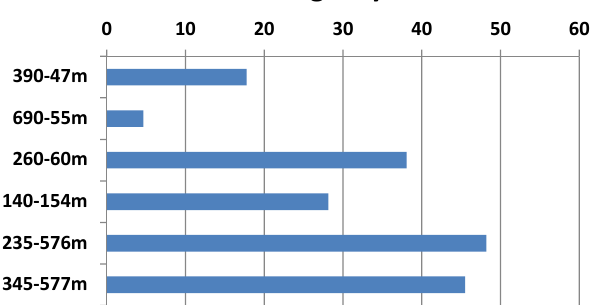
Fig. 7. Percentage contribution of the C 25 monounsaturated hydro- carbon (sea ice IP 25 biomarker) to the total algal hydrocarbons in sediments from the Mackenzie Shelf and slope. Total algal hydro- carbons include the IP 25 n -C 15 , n -C 17 , n -C 19 , n -C 21 : 6 , n -C 21 : 5 and n -C 21 : 4 .